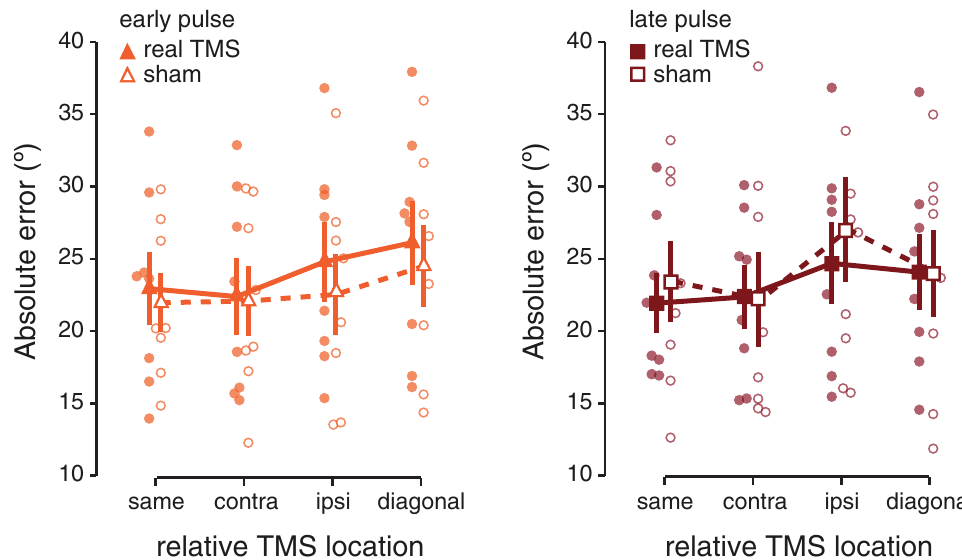
Fig 4. Absolute recall errors during real and sham TMS. (A) Performance when real or sham pulses were appliedearly duringretention, directly at stimulus offset. (B) Performance for pulses (real or sham) applied midwaythrough the retention interval. Transparentdots indicate individual participantdata, error bars depict ± 1 SEM.